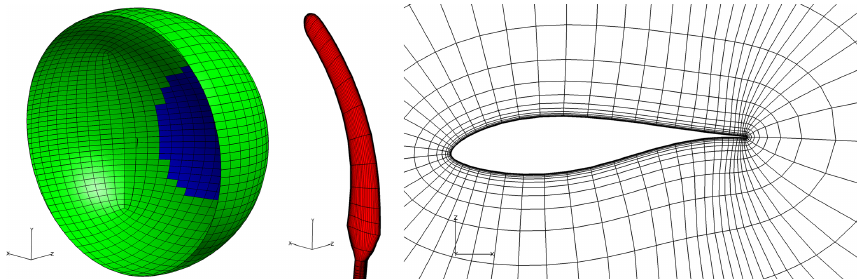
Figure 11. Visualization of the EllipSys3D mesh. For clarity, only one out of every four grid lines is shown. Left: overview of the boundary conditions distribution. Half of the spherical domain is not depicted and the freestream velocity vector is aligned with z axis. Green color corresponds to inlet and blue to outlet. Middle: detail of surface mesh around the walls, here depicted in red. Right: cross-sectional mesh around the tip at half of the projected